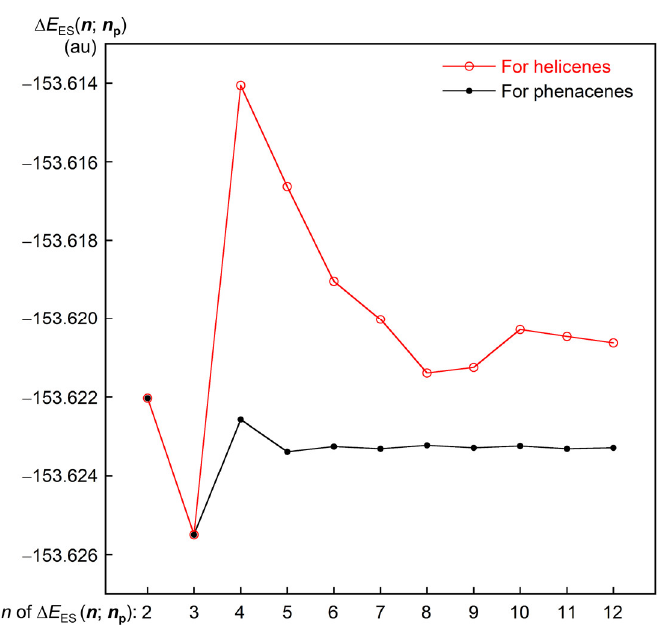
Figure 1. Plot of ∆ E ES ( n ) and ∆ E ES ( n p ) versus n , evaluated with M06-2X/6-311+G(3d,p), where Figure 1. Plot of Δ E ES ( n ) and Δ E ES ( n p ) versus n , evaluated with M06-2X/6-311+G(3d,p), where Δ E ES ( n ) ∆ E − E − 1) and ∆ E − E − = E ES ( n ) − E ES ( n − 1) and Δ E ES ( n p ) = E ES ( n p ) – E ES ( n p − 1). ES ( n ) = E ES ( n ) ES ( n ES ( n p ) = E ES ( n p ) ES ( n p